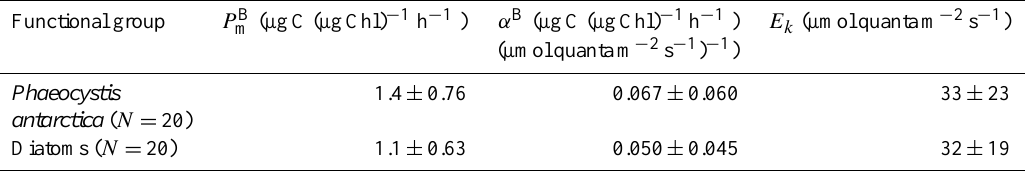
Table 5. Comparison of the mean photosynthesis–irradiance parameters as a function of phytoplankton composition (means and standard deviations). Dominance was determined by either chemical or microscopic analyses. Twenty stations for each functional group ( N ) from the entire data set were selected for inclusion in this comparison. No significant difference in any photosynthetic parameter was detected. Functional